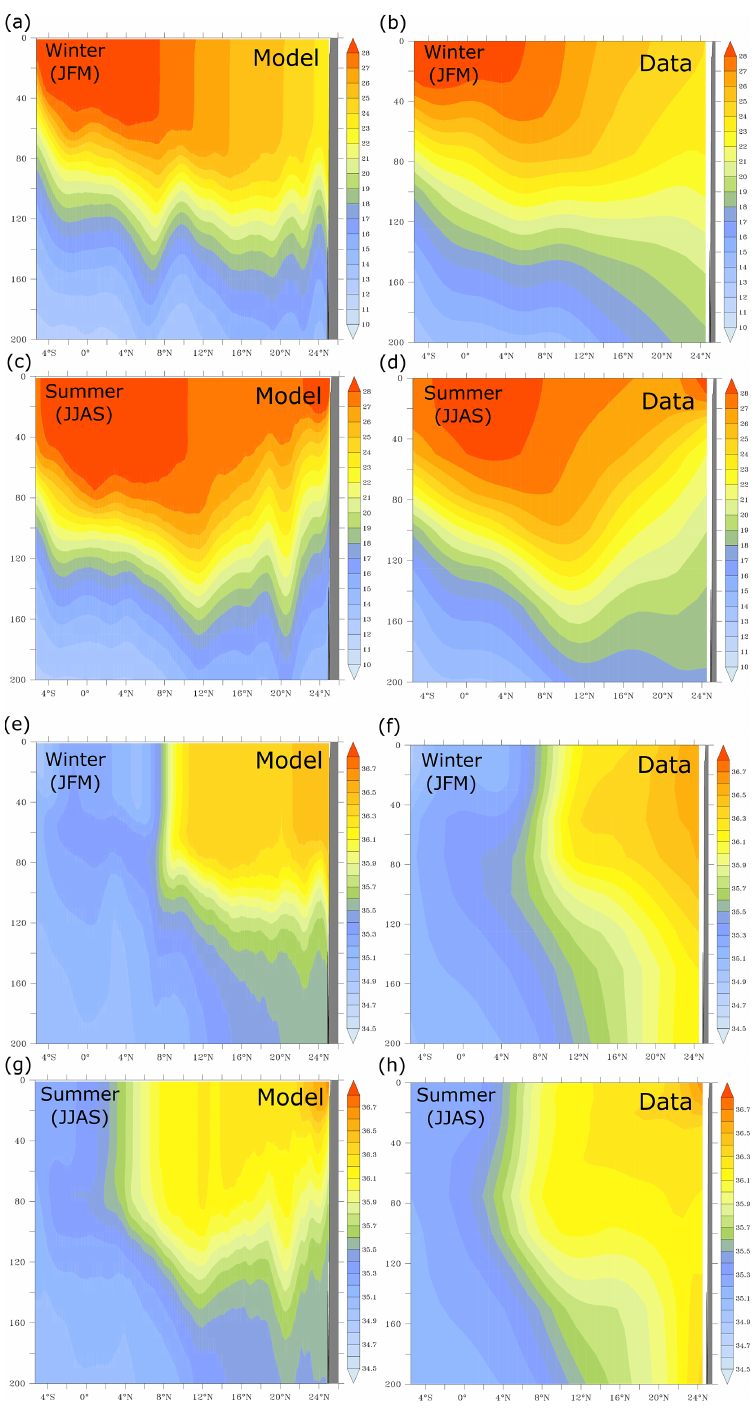
Figure A4. Vertical distributions of temperature and salinity in the upper ocean. (a–d) Meridional distribution of temperature in the upper 200m along 62 ◦ E as simulated in ROMS (a, c, e, g) and from the World Ocean Atlas (2009) dataset (b, d, f, h) during winter and summer months. (e–h) Meridional distribution of salinity in the upper 200m along 62 ◦ E as simulated in ROMS (a, c, e, g) and from the World Ocean Atlas (2009) dataset (b, d, f, h) during winter and summer